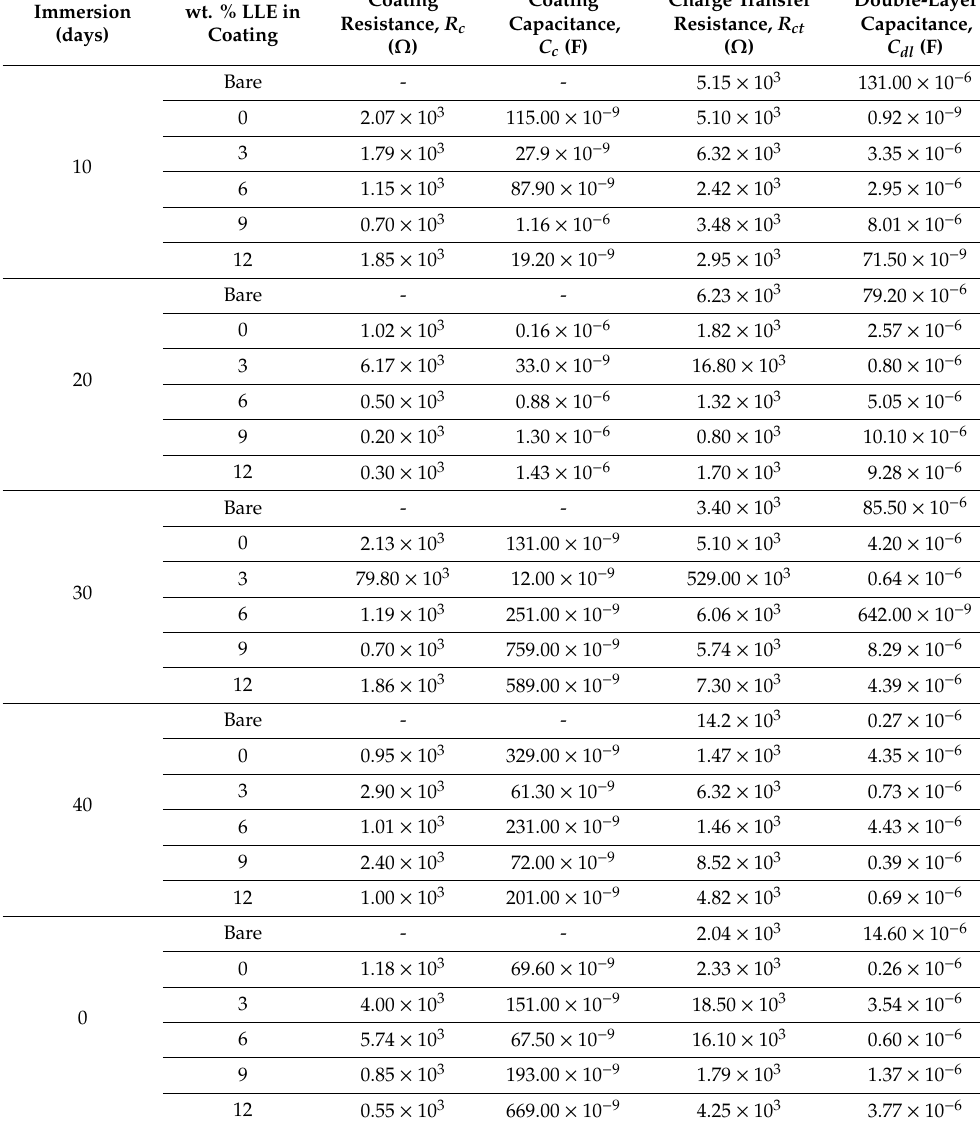
Table 7. Impedance